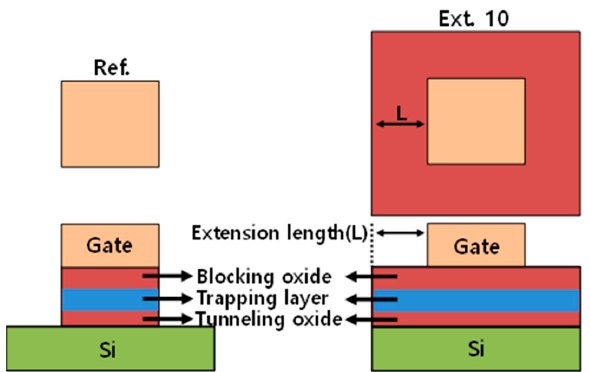
Figure 4. Lithography mask layout to fabricate the test device with a cross-sectional view of the device. Here, Ext. 10 means the extension length of the charge trapping layer was 10 μ m. In the case of Ref., the charge trapping layer was etched and self-aligned with the gate and the extension length is 0 μ